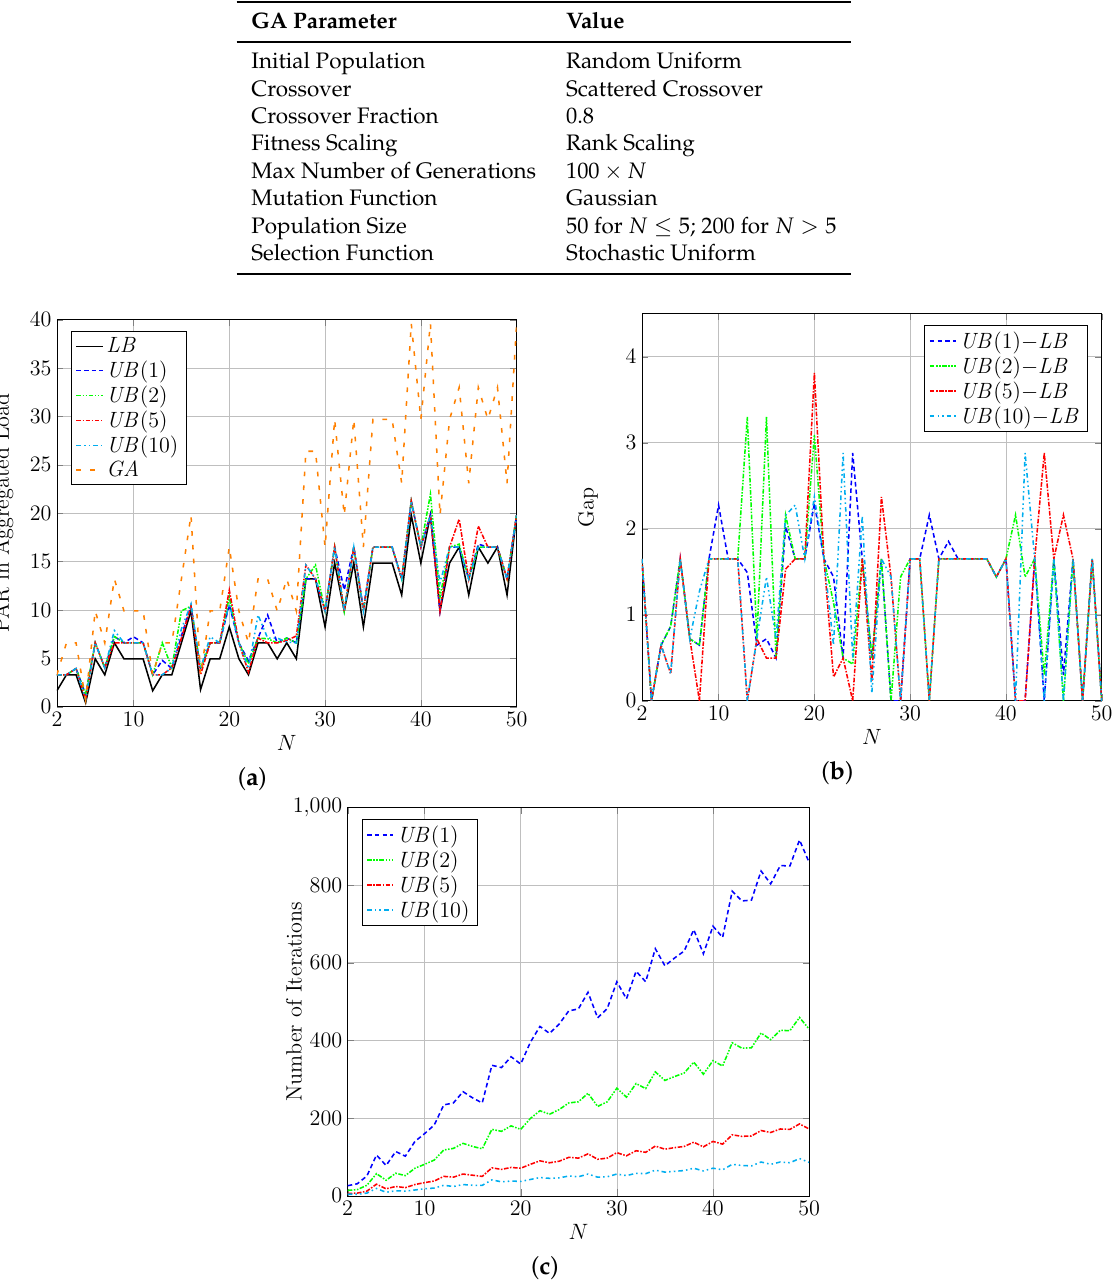
Figure 6. Atomic energy consumption scheduling for PAR minimization: ( a ) Upper ( UB ) and lower bounds ( LB ); ( b ) gaps; and ( c ) number of